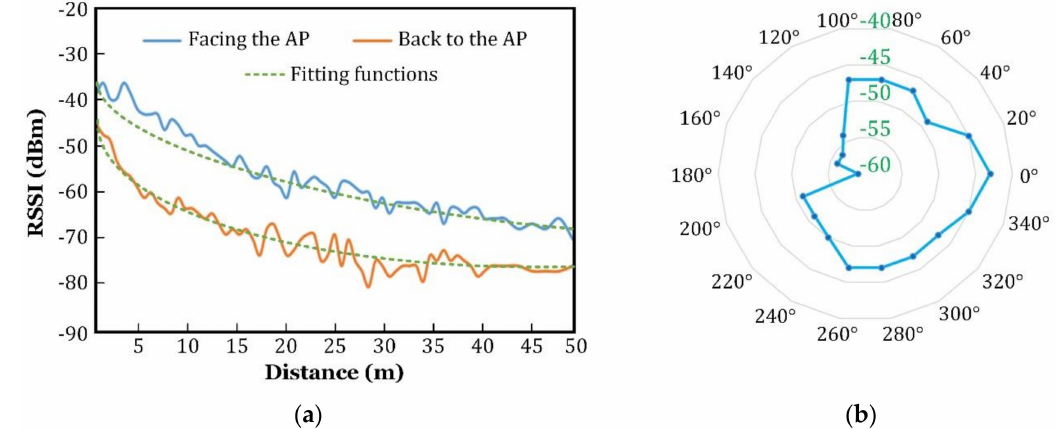
Figure 8. The measured RSSI profiles. ( a ) When the user holds the smartphone and walks; ( b ) when the user holds smartphone and